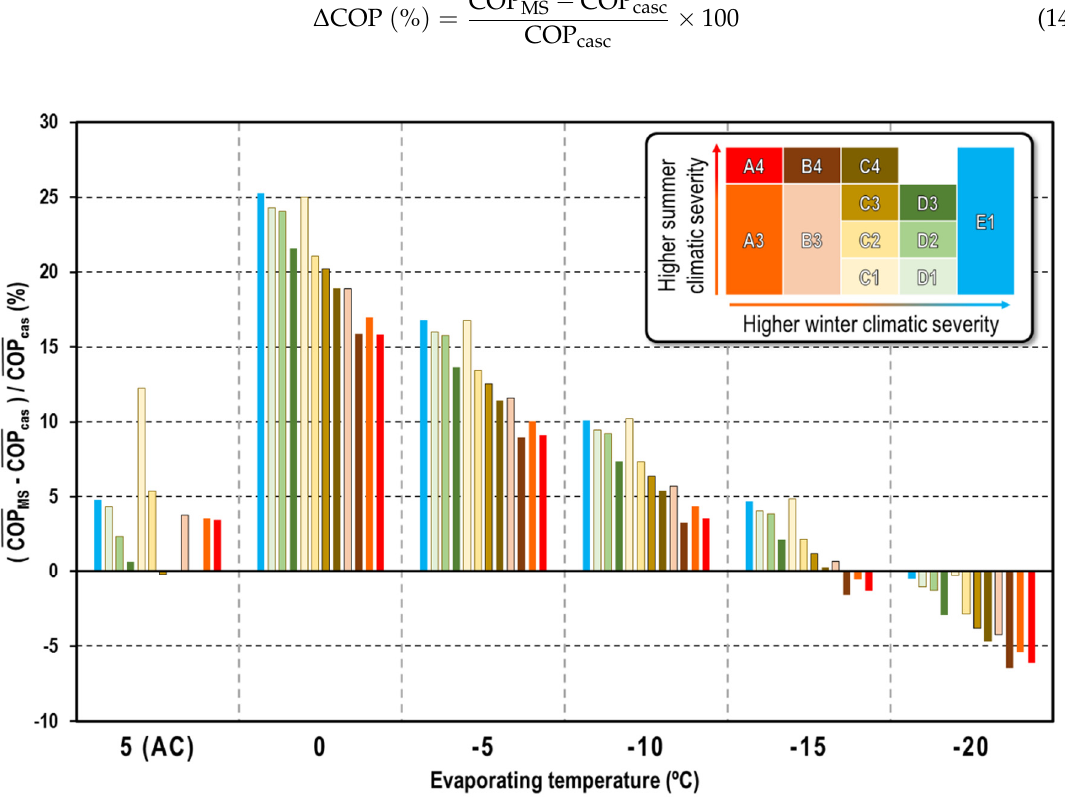
Figure 15. COP percentage variation of MS cycle vs. the cascade system at different climatic condition.